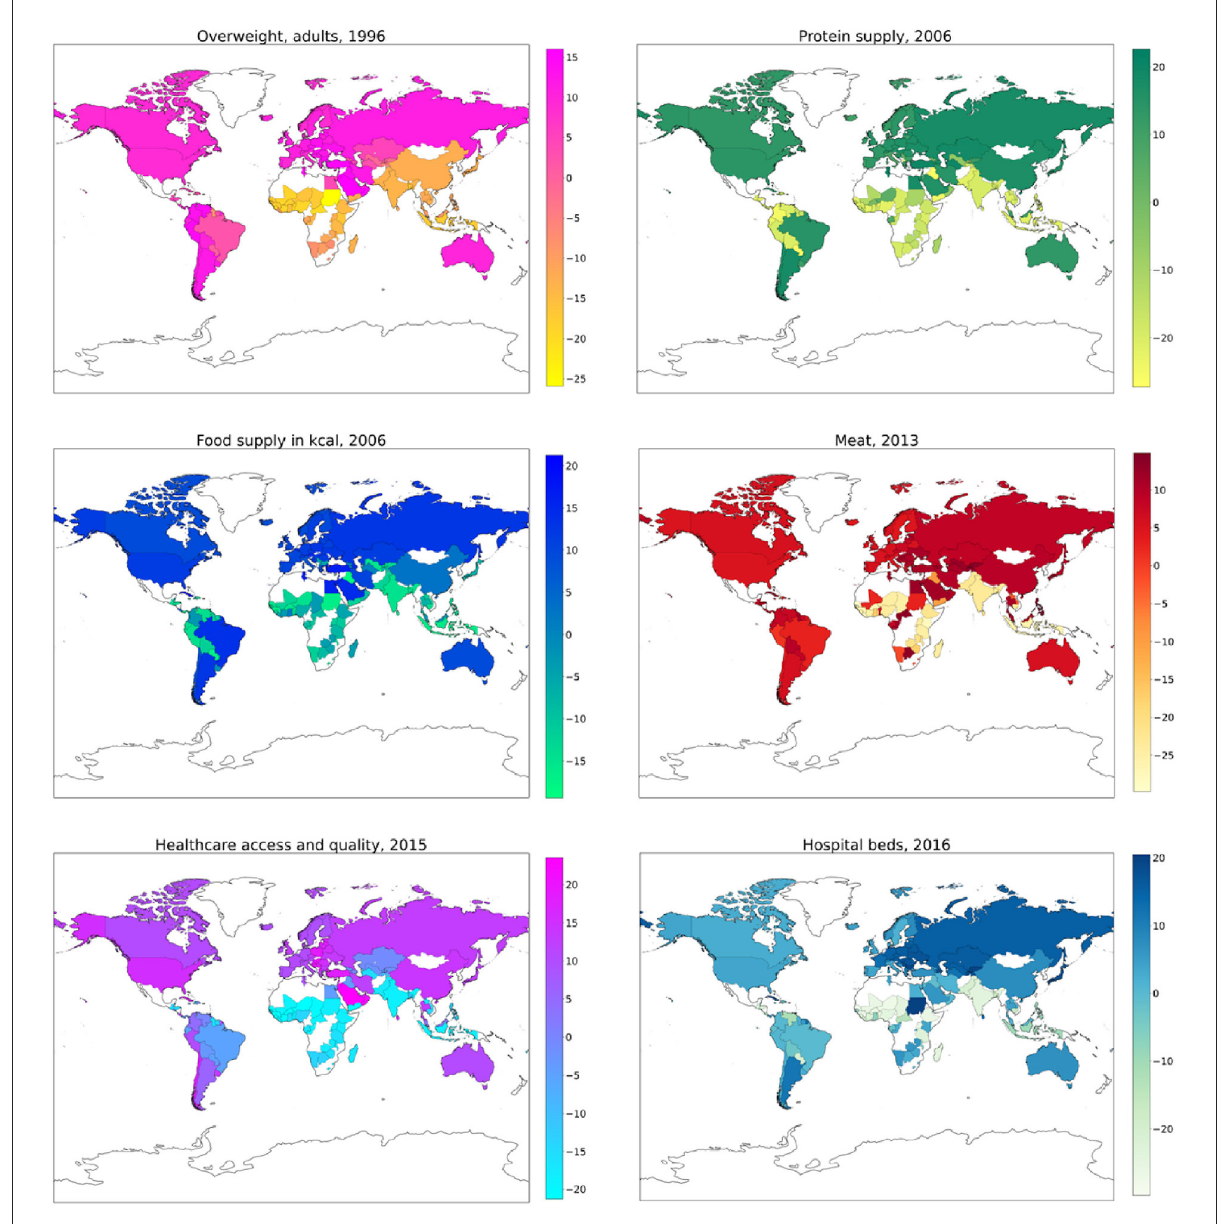
FIGURE9 World maps of SHAP values associated with PAD prediction, related to the feature and year indicated in the each map label. Color bars are reported for numerical